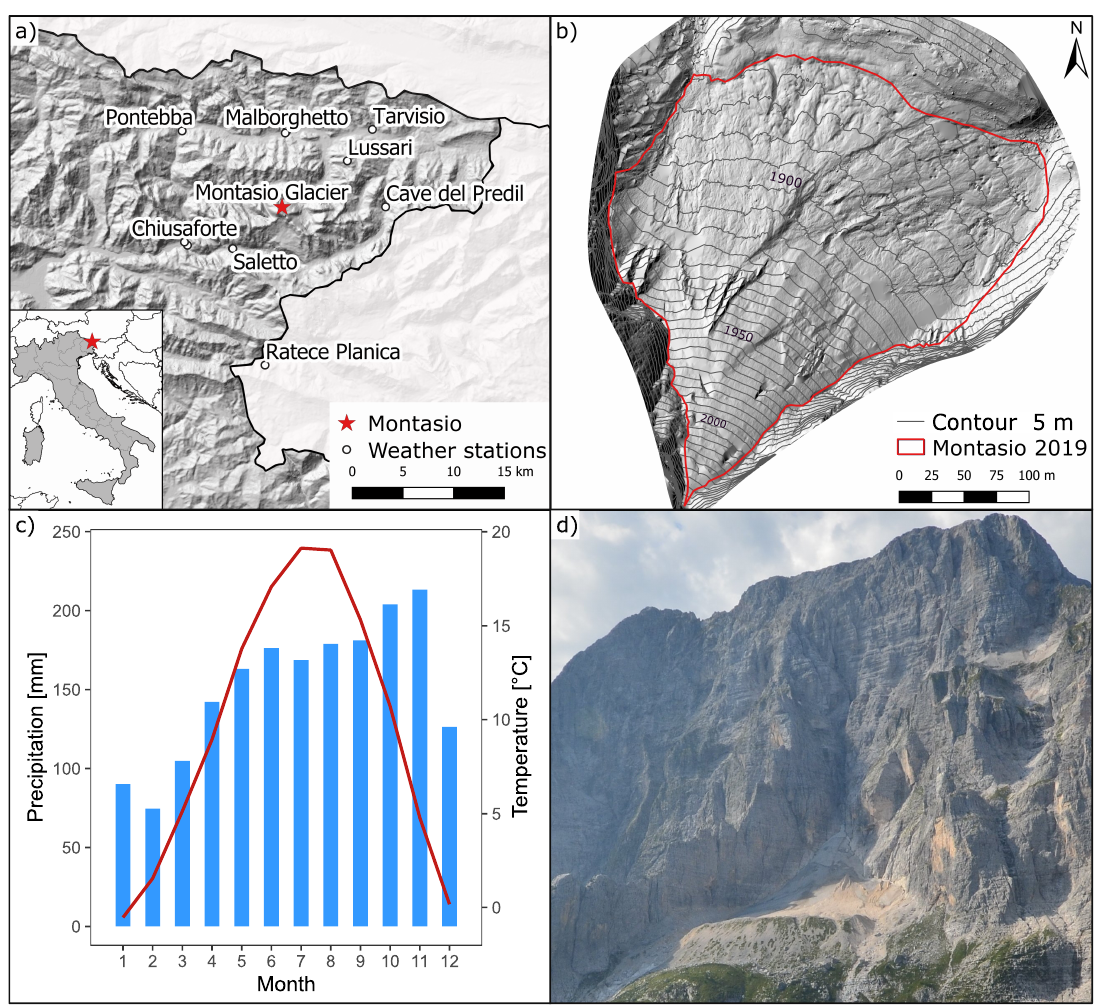
Figure 1. ( a ) Geographic setting of the Montasio Glacier and of the weather stations in the study area; ( b ) glacier topography over the shaded relief map of the high-resolution 2019 SfM survey; ( c ) monthly temperature and precipitation climatology in the period from 1960 to 2009 at the Pontebba weather station; ( d ) photo of the glacier and northern walls of the Mount J ô f di Montasio (Photo F. Cazorzi, 16 August